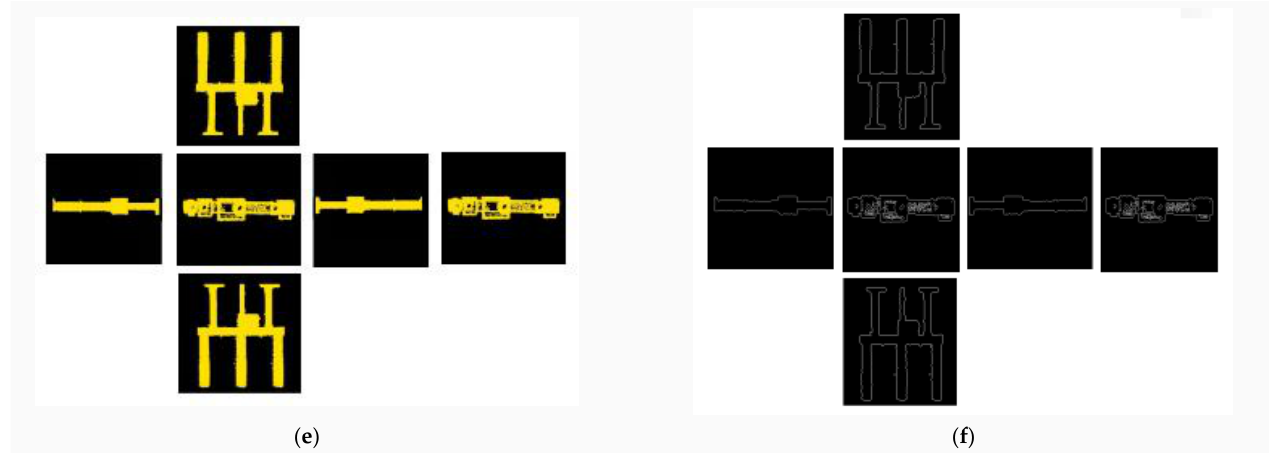
Figure 9. Edge feature of Canny. ( a ) The 3D CAD model of the voltage transformer; ( b ) 3D point cloud model of the voltage transformer. ( c ) Projected view of the voltage transformer; ( d ) edge extraction diagram of the voltage transformer; ( e ) point cloud projection view of the voltage transformer; ( f ) edge extraction of the Pt point cloud. Table 3. The algorithm proposed in this paper, the D2 algorithm, and the model screening results of the two-dimensional image proposed by Shih et al. [16].